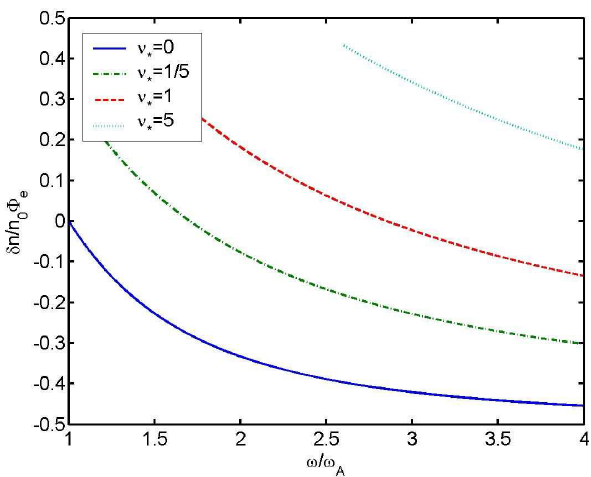
Fig. 3. The particle number density perturbations as the function of the wave frequency. Other parameters are the same as in Fig. 1.